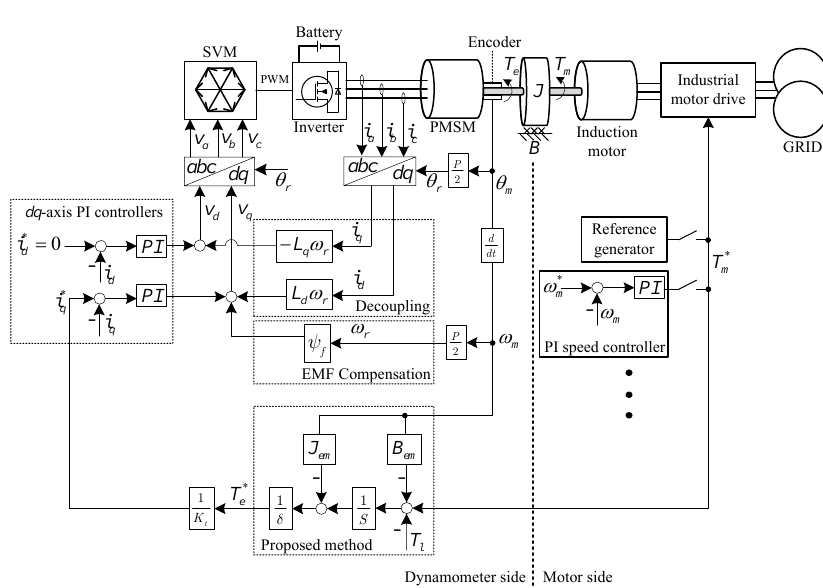
Figure 5. Experimental system.